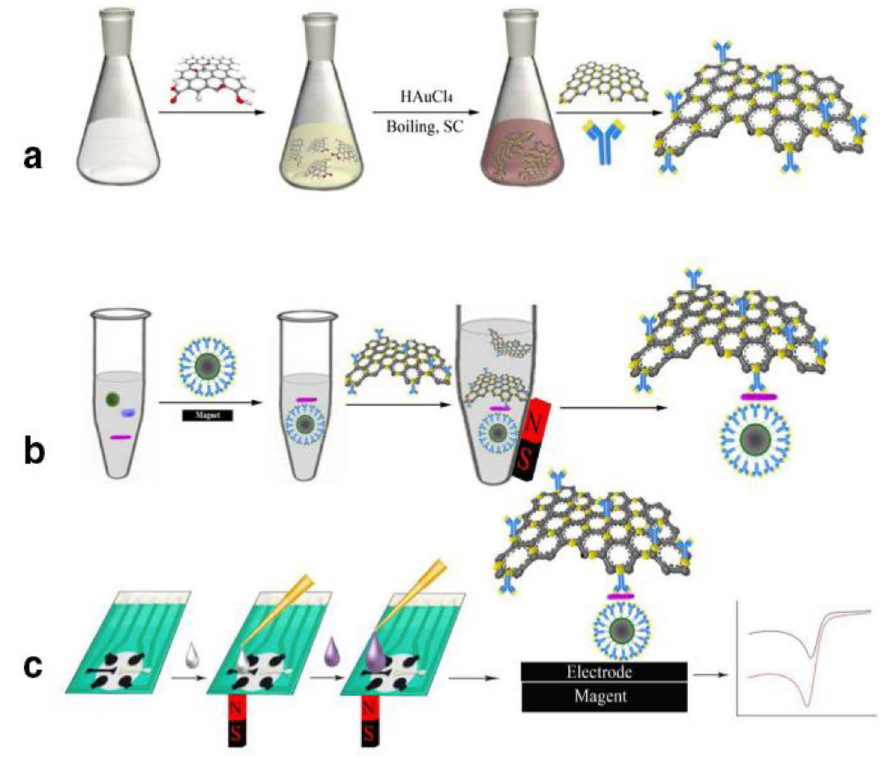
Figure 6. Fabrication of the electrochemical immunosensor for Salmonella pullorum and electrochemical detection: Synthesis process of rGO/Au/Ab2 ( a ); Capture of Salmonella pullorum from samples by MMPs ( b ); Put a MMPs-immunoconjugates drop on the SPCE and electrochemical detection ( c ). Reprinted from Ref. [82] with